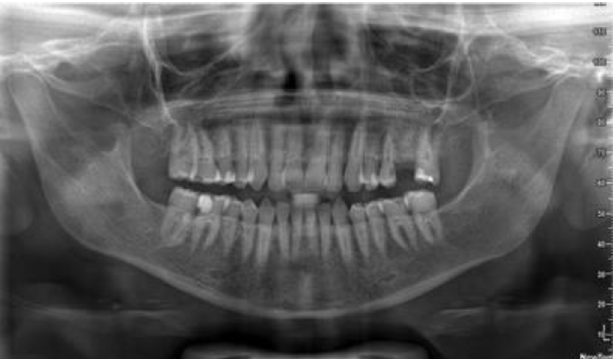
Fig. 5. Orthopantomogram. The panoramic radiograph shows the absence of the wisdom tooth and the fi rst left upper molar. The bone volume is suf fi cient in the gap between 25 and 27 for an implant placement.